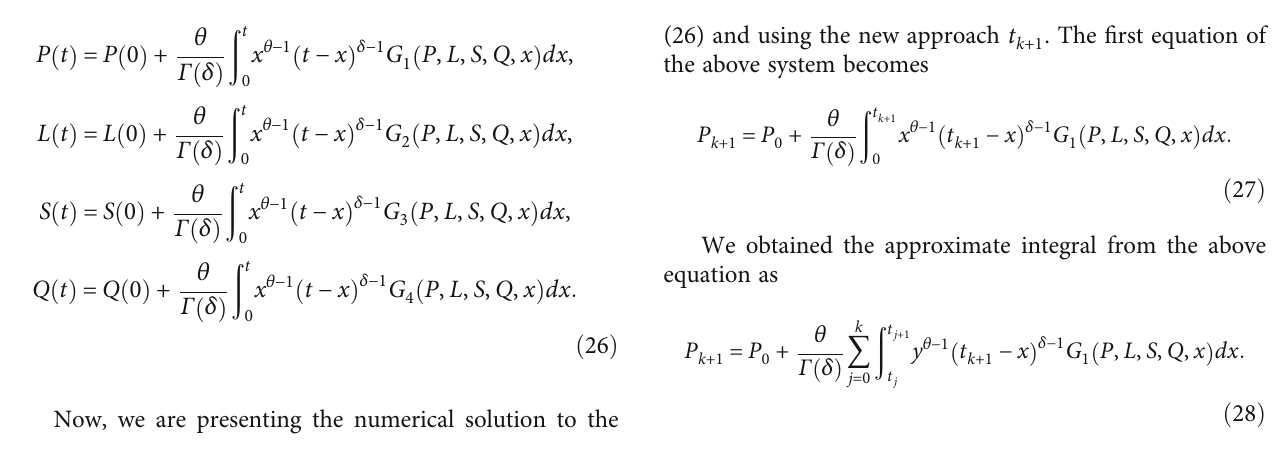
Figure 1: Graphical representation of potential smokers ( P ð t Þ ) having two di ff erent initial values of P investigation (1) at di ff erent arbitrary fractal dimension and fractional